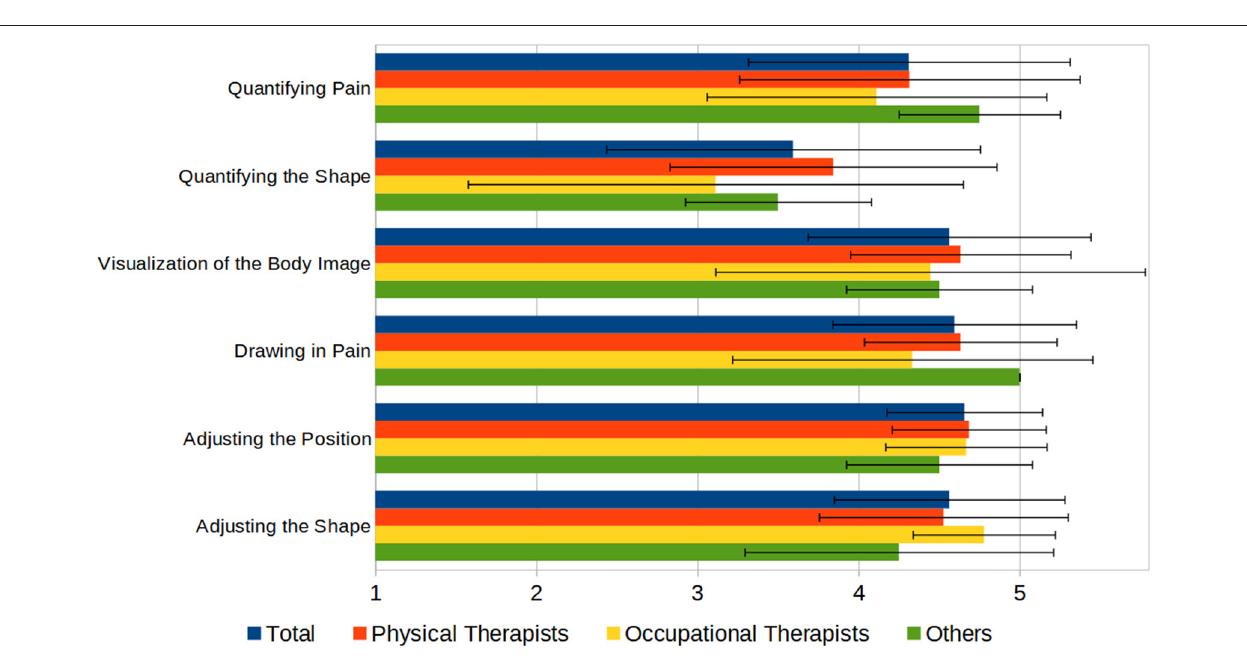
mentioned very frequently, not only in relation to phantom the modeling and positioning of the body parts, here a more